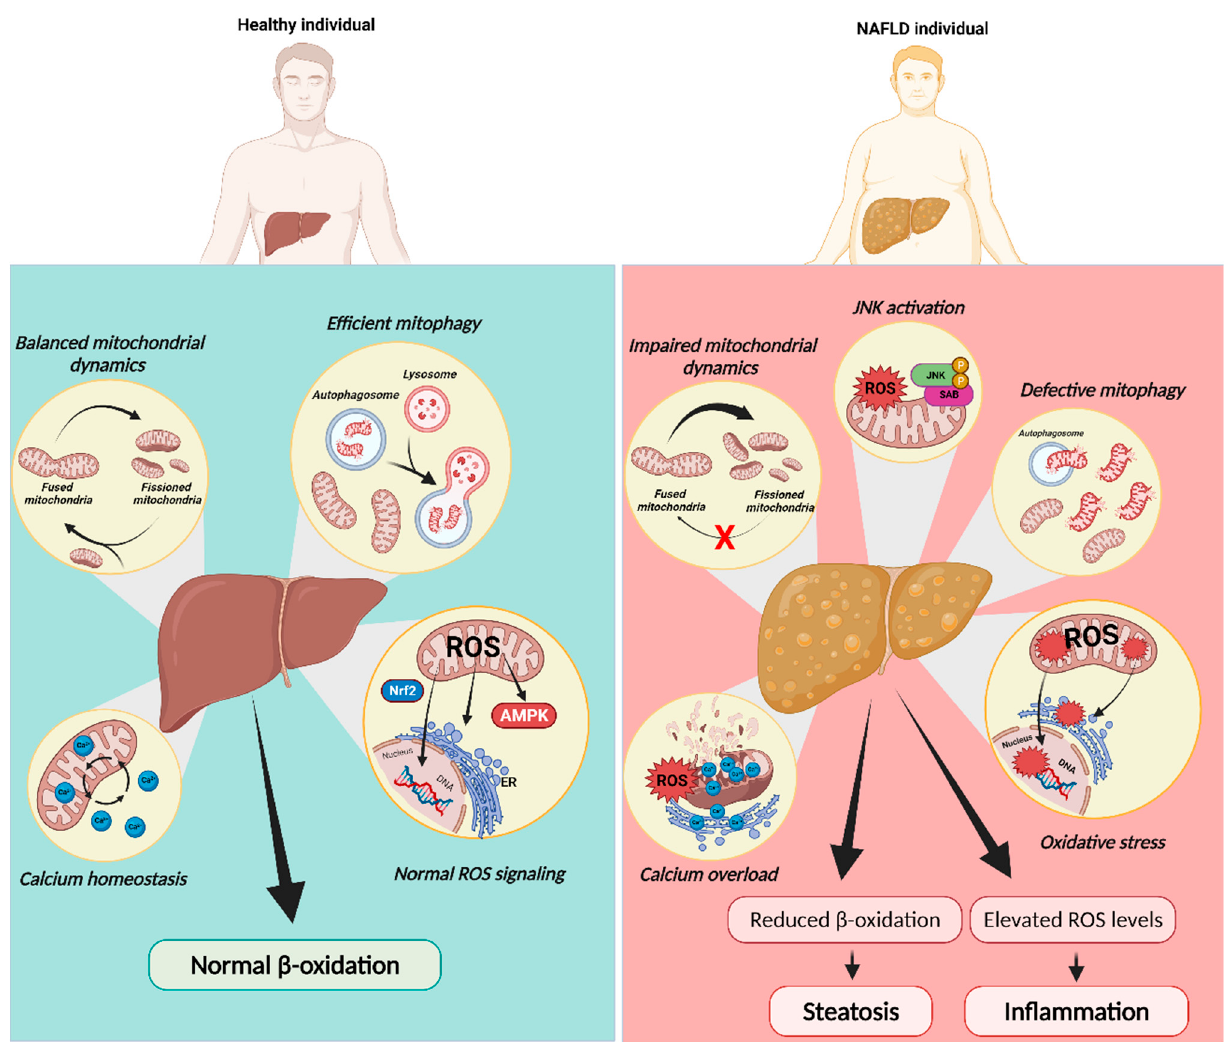
Figure 3. Mitochondrial dysfunction in NAFLD progression. Mitochondria rely on diverse mech- anisms to preserve their function including dynamics, redox signaling, mitophagy, and calcium homeostasis. In contrast to a healthy liver, mitochondria in NAFLD were reported to be fragmented and overloaded with calcium, with decreased oxidative capacity and increased ROS production, which cause JNK activation. JNK activation itself can induce these same defects in mitochondrial function, constituting a feed-forward cycle of mitochondrial dysfunction. Mitochondrial dysfunction in NAFLD was also explained by defective mitophagy. The decrease in fatty acid oxidation (FAO) caused by this compromise in mitochondrial function may induce FA accumulation in hepatocytes while impairing insulin signaling. ER, endoplasmic reticulum; JNK, c-Jun NH2-terminal kinase; SAB, SH3 homology associated BTK-binding protein; ROS, reactive oxygen species. Created with BioRender.com (accessed on 5 February